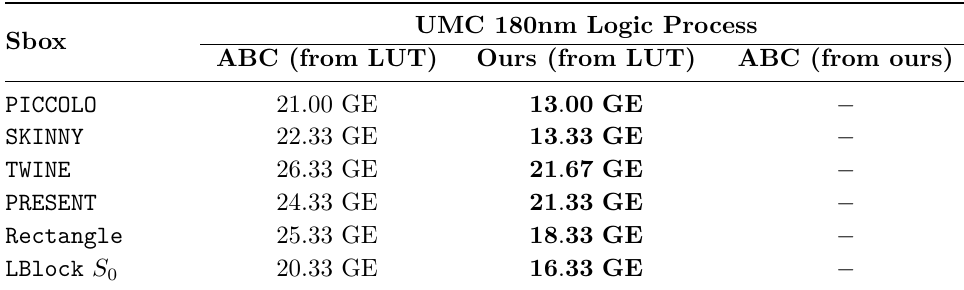
Table 10: Comparison of area-optimized synthesis on the UMC 180nm